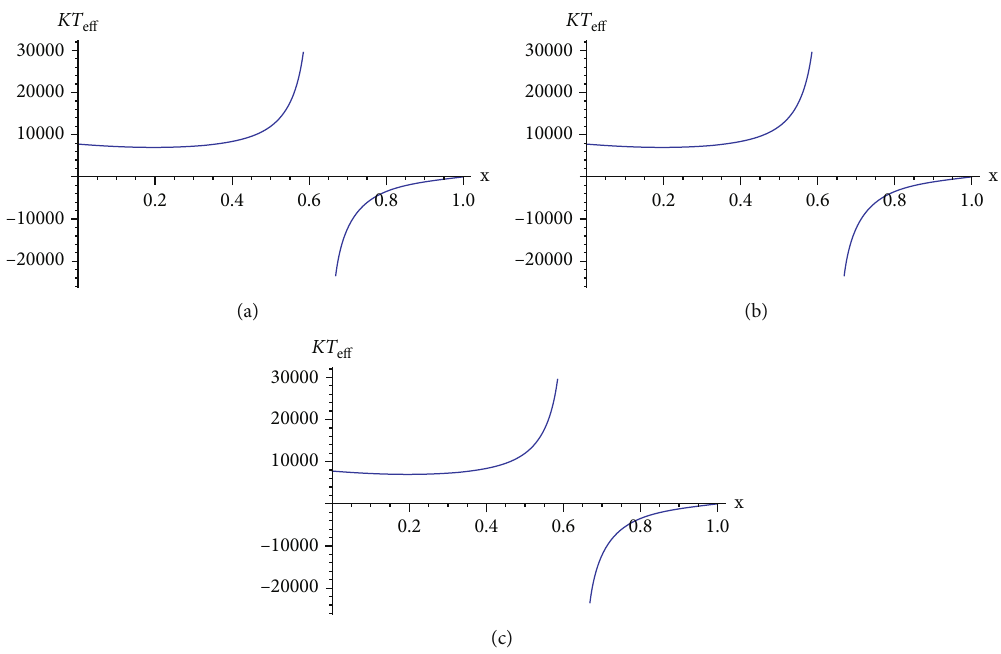
− x curves with l 2 = 100 , and (a) for ϕ 2 T eff